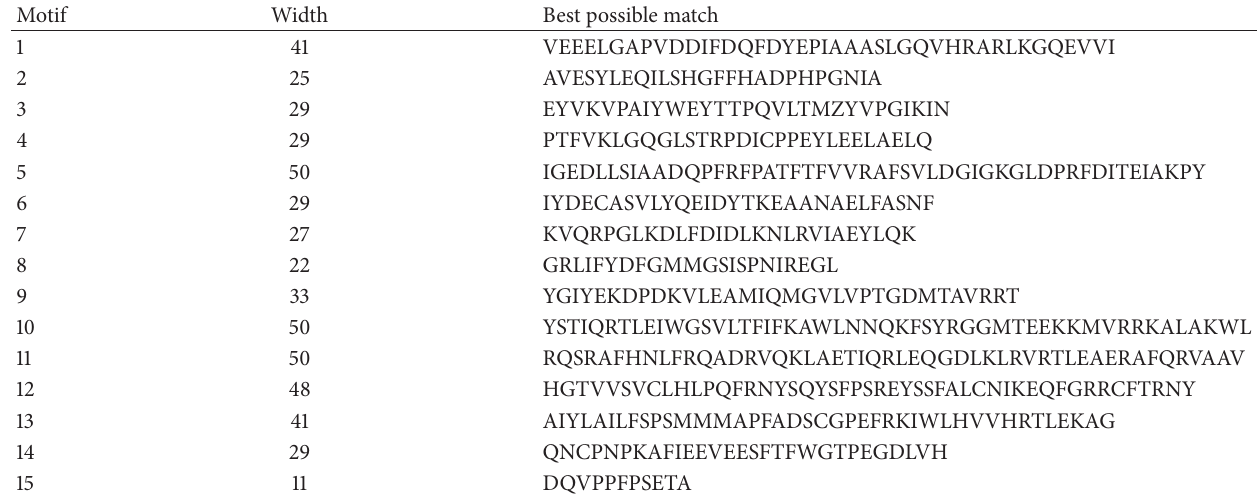
Table 2: Motif sequences of the P. trichocarpa ABC1 genes identified using MEME